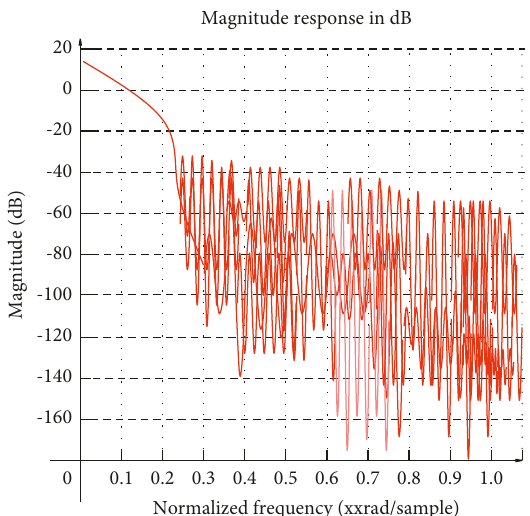
Figure 9: Frequency response of FIR low-pass filter with a nor- malized cutoff frequency 0 . 125 π .